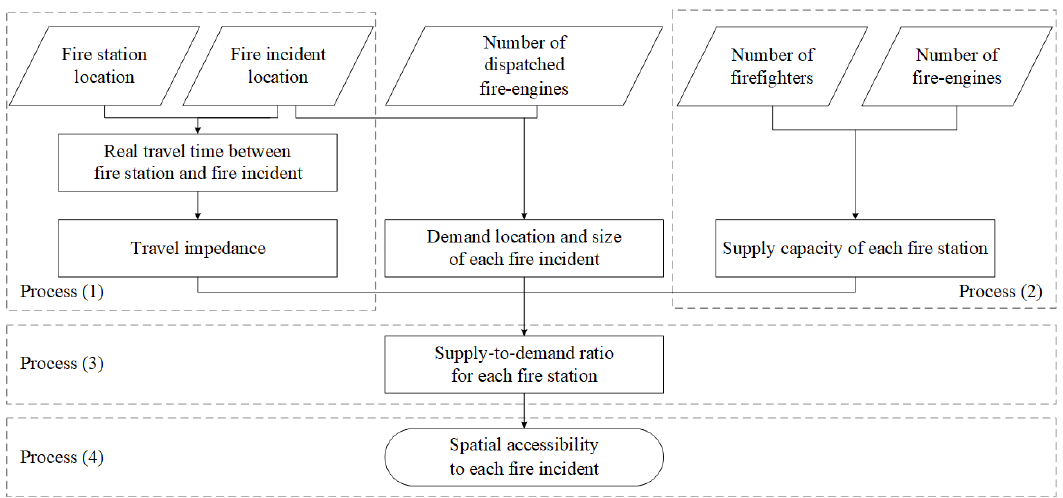
Figure 3. Flowchart of the proposed fixed-coverage-based two-step floating catchment area (FC2SFCA)